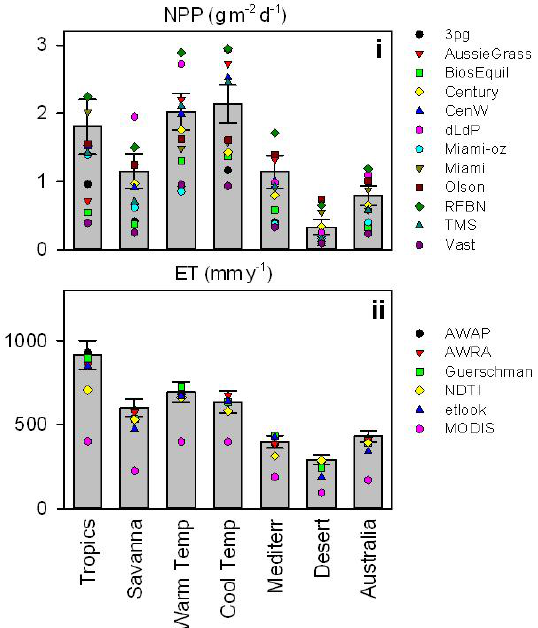
Fig. 17. BIOS2 estimates of long-term NPP and ET by bioclimatic region. Superimposed are multiple model estimates of NPP (Rox- burgh et al., 2004) and ET (King et al.,